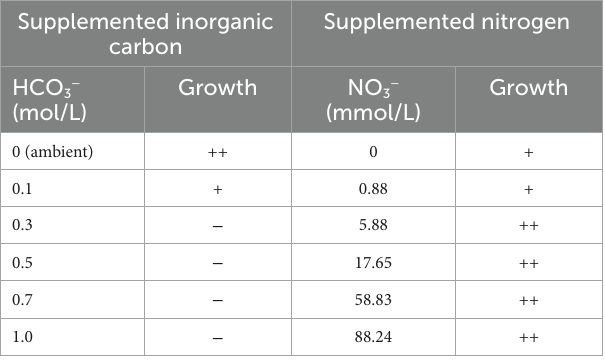
TABLE 5 Physiological characteristics of Trichothermofontia B231 grown in 47 ° C, 150 μ mol m − 2 s − 1 under varying carbonate and nitrate